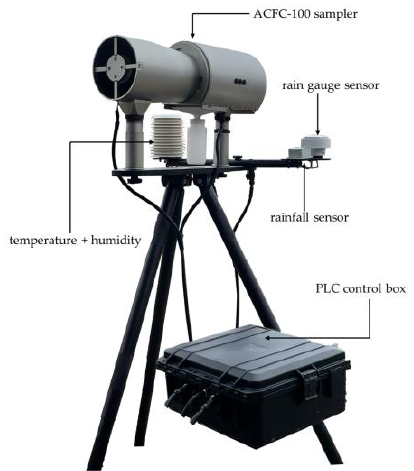
Figure 1. Complete view of the ACFC. Above the PLC control box with a platform anchored by a tripod and the sampler with automatic baffle, plus the sensor module.